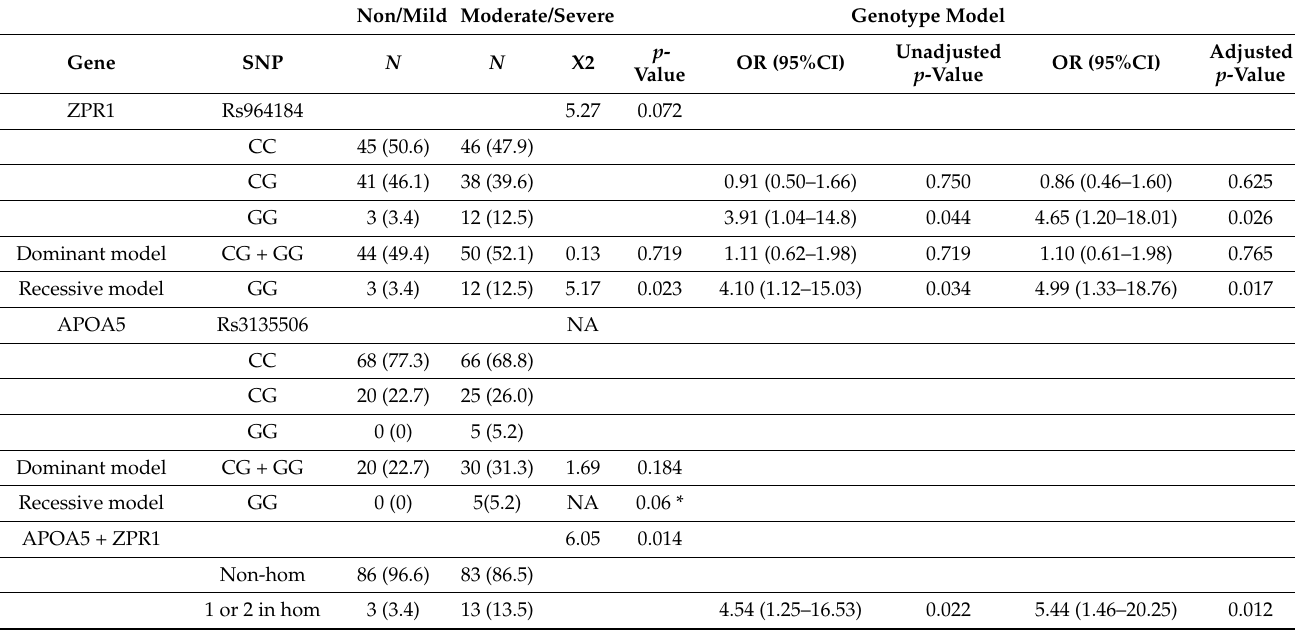
Table 2. Genotype frequencies and odds ratios of variants associated with non-alcoholic fatty liver disease.